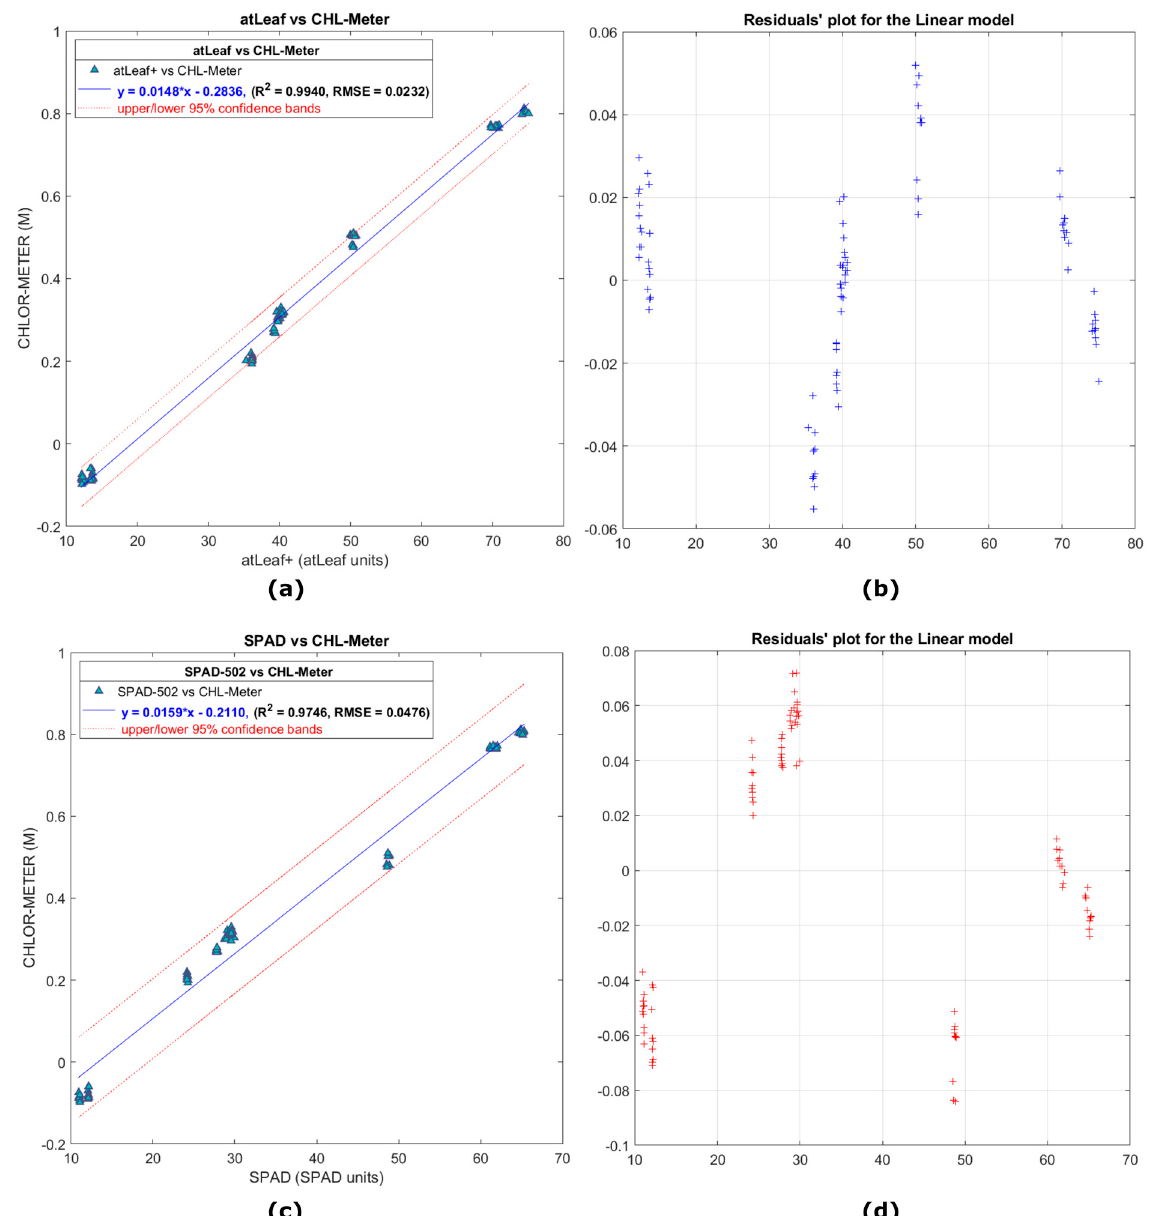
Figure 9. In ( a ), a scatter plot showing the correlation of data measurements with atLeaf CHL Plus and in ( c ), with SPAD-502 as compared to the proposed sensor, with only the 9 green color filters (numbered as 1, 2, 3, 4, 7, 8, 9, 10, and 13 in Figure 7) used. ( b , d ) Plots of the residuals (marked with + in the Figure) for the simple linear regression model fit applied on data and plotted on ( a , b ). The norm of the residuals was calculated to be 0.2205 and 0.4520, for the atLeaf and SPAD-502, respec- tively.